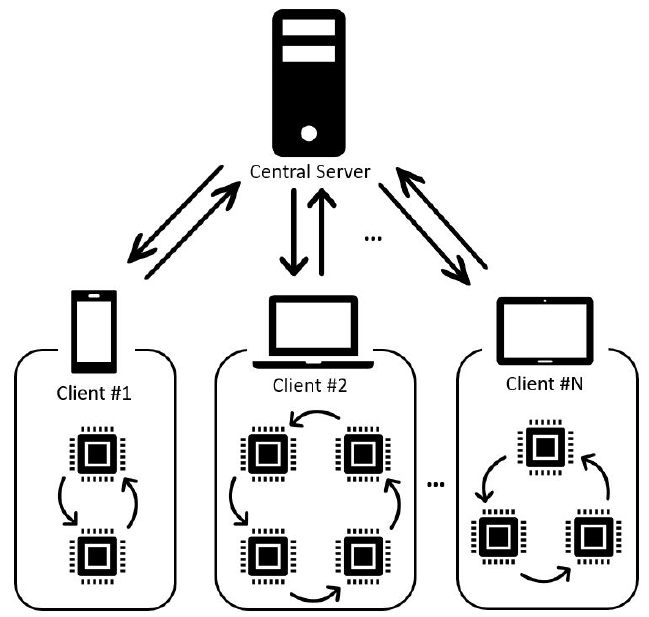
Figure 1. Concept of embedded AI system supporting federated learning.